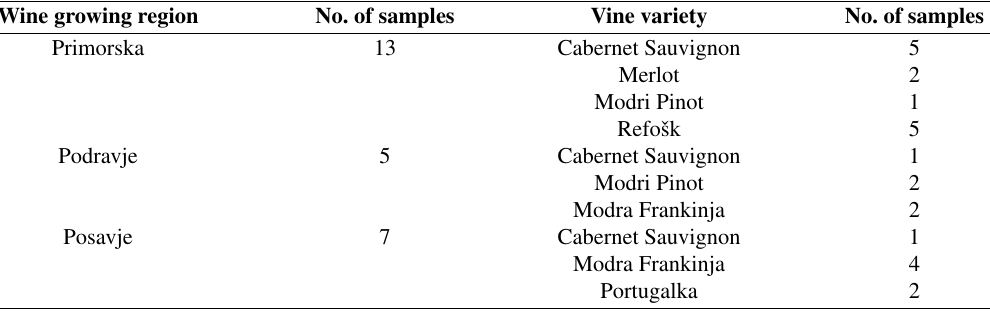
Merlot Modri Pinot Refo{k